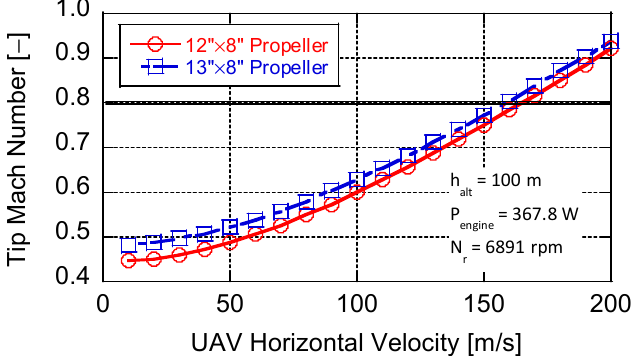
Figure 10. Propeller tip Mach number values as a function of UAV speed.